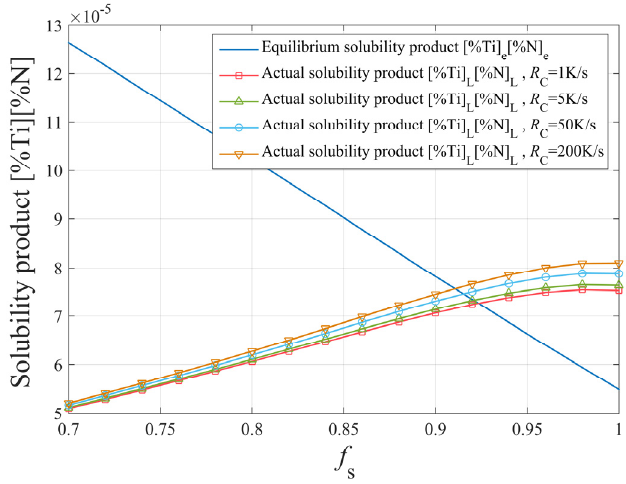
Figure 10. The effect of cooling rate on the segregation of solute elements Ti and N.